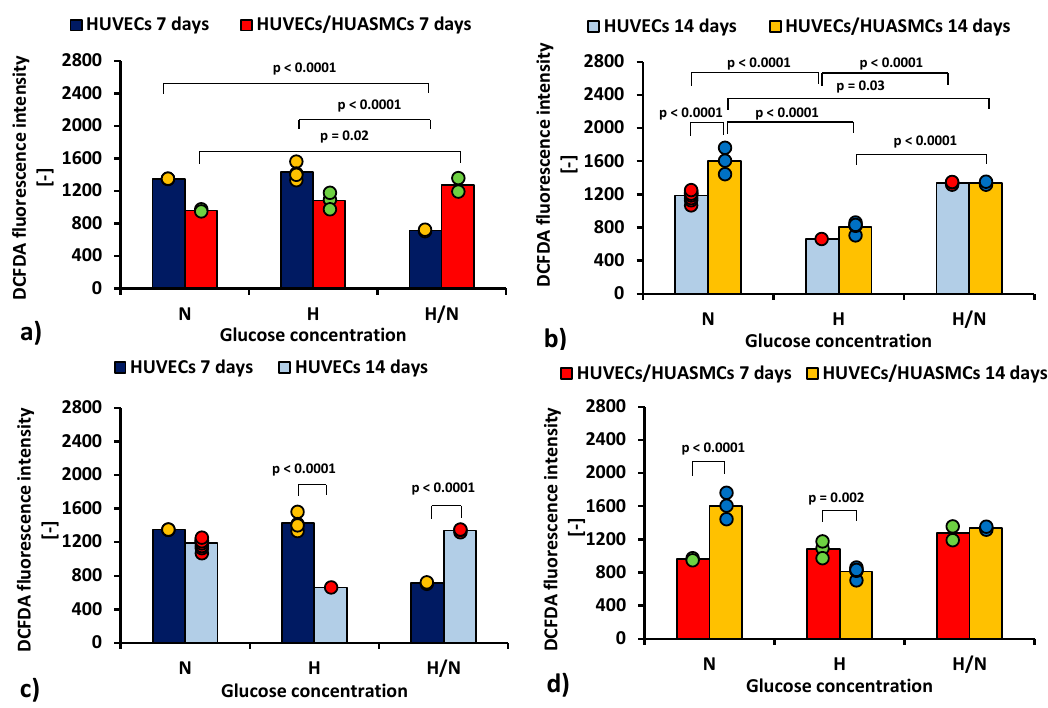
Figure 4. ROS production (DCFDA geometrical mean of the fluorescence intensity in cytometric analysis) by HUVECs: after 7 days of culturing without HUASMCs or co-culturing with HUASMCs ( a ); after 14 days of culturing without HUASMCs or co-culturing with HUASMCs ( b ); after 7 and 14 days of culturing without HUASMCs ( c ); after 7 and 14 days of co-culturing with HUASMCs ( d ); in normal (N), high (H), or variable (H/N) glucose concentration on PSU flat membranes covered with fibronectin. The data are presented as scatter plot (yellow, green, red and blue dots) with corresponding bar graphs.